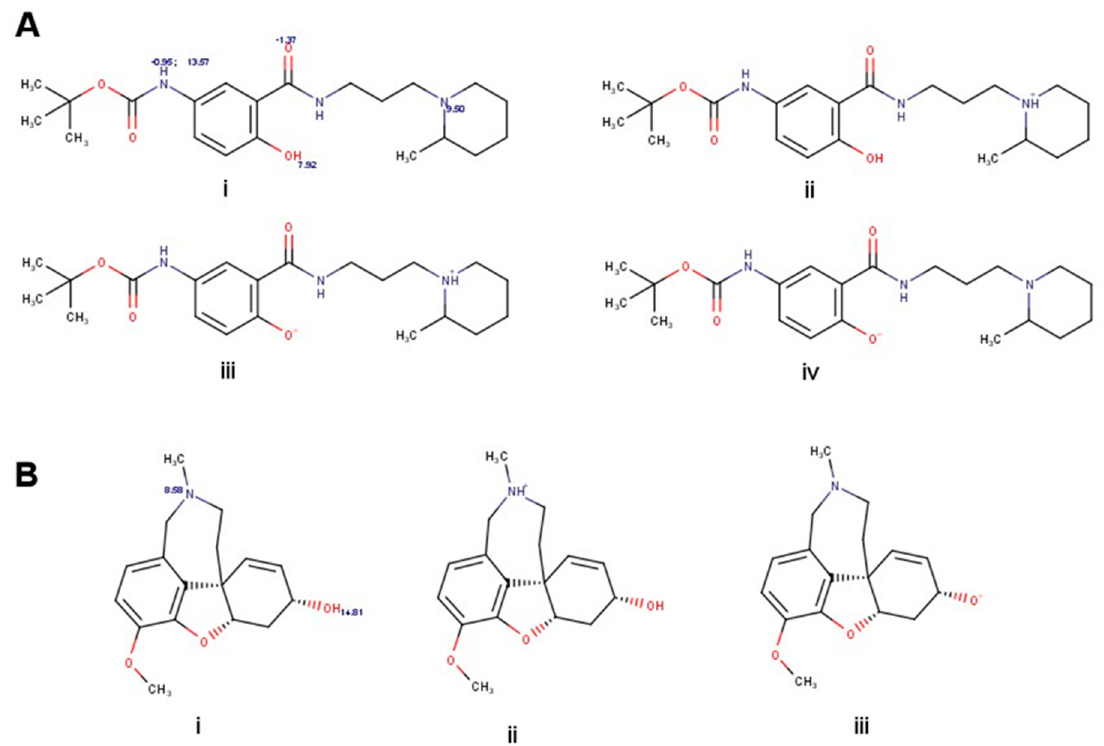
Molecules 2020 , 25 , x FOR PEER REVIEW Figure 7.